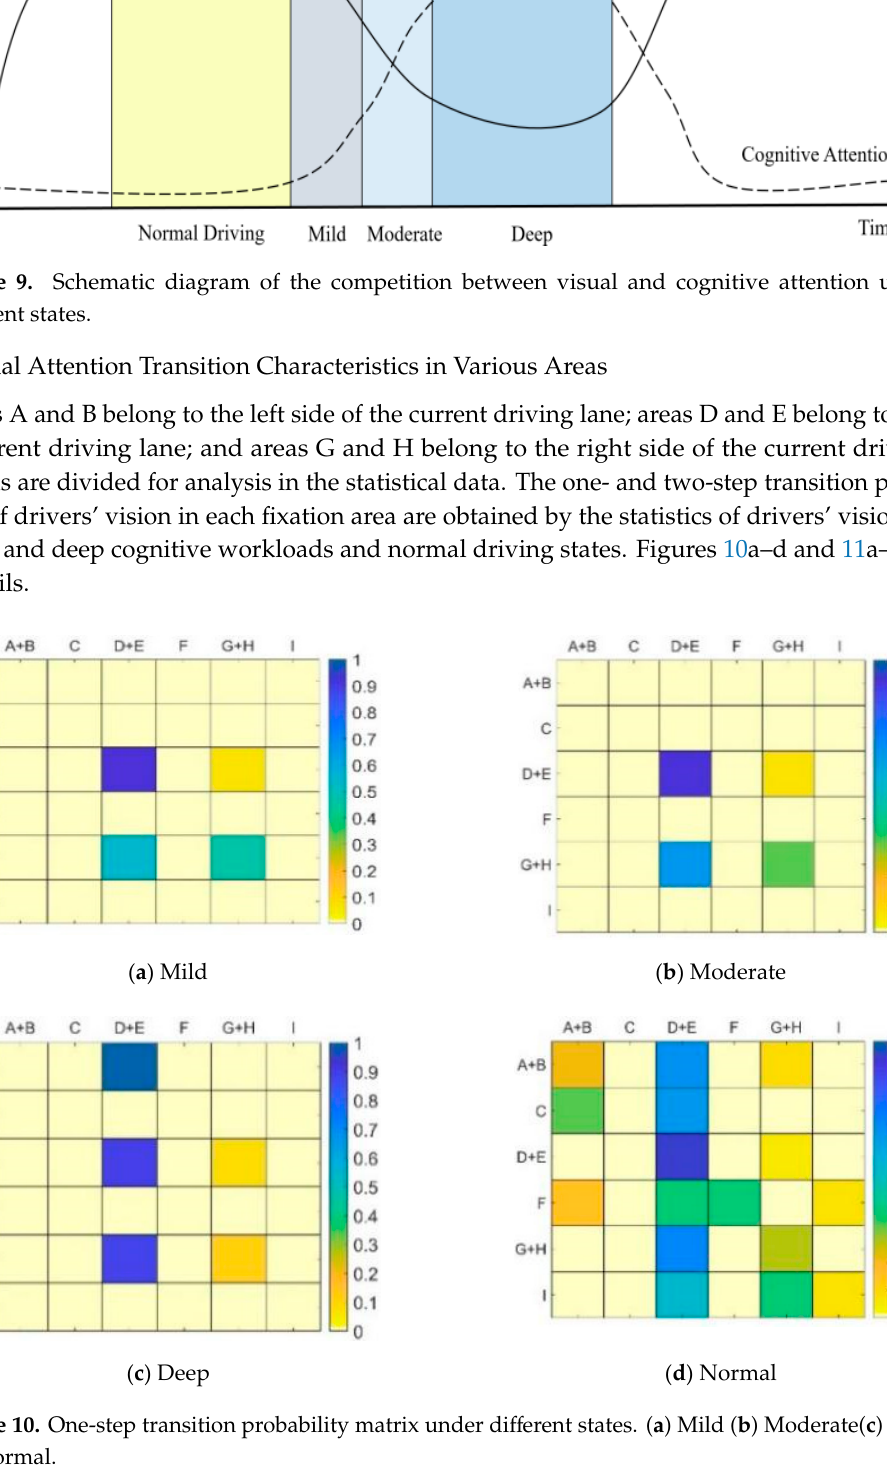
Figure 8. Driver’s fixation transition trajectory under different states. ( a ) Mild cognitive workload ( b ) Moderate cognitive workload ( c ) Deep cognitive workload ( d ) Normal driving. Note: In order to better display the data, we use squares to indicate areas where the data are concentrated. Based on previous works [39] and the outcome of this study, visual and cognitive rules occupying drivers’ attention in different states are obtained. As illustrated in Figure 9, the cognitive and visual effects on drivers’ total attention can be derived; in normal driving conditions, drivers can pay close attention to all areas due to sufficient visual resources. When mild cognitive workload occurs and occupies attention resources, the workload is lower than the visual resources. Drivers can